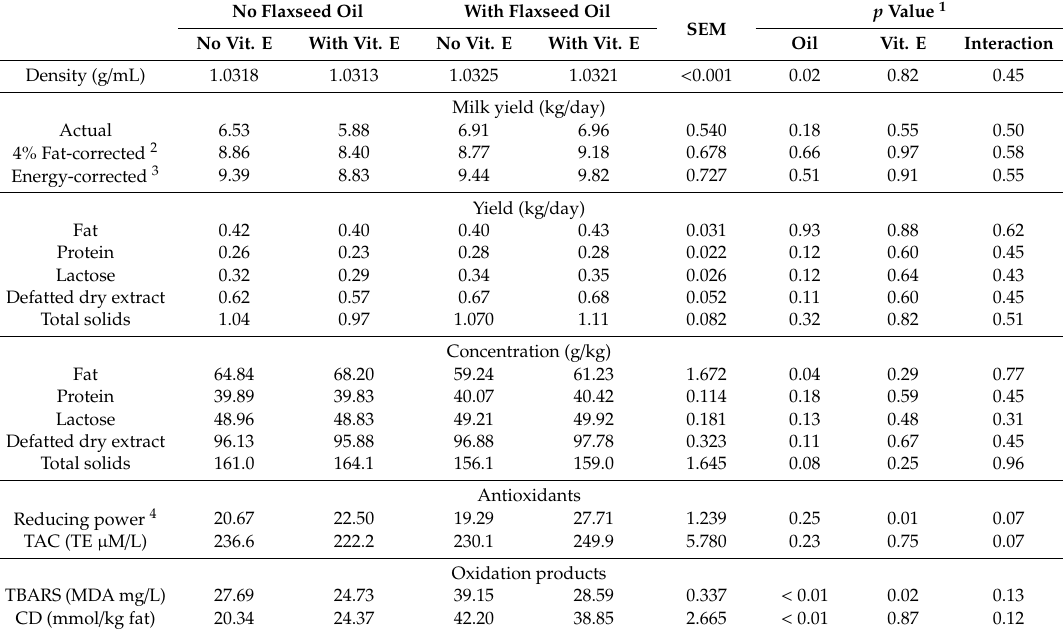
Table 3. Composition and antioxidant capacity of milk from lactating bu ff aloes fed diets containing flaxseed oil and / or vitamin